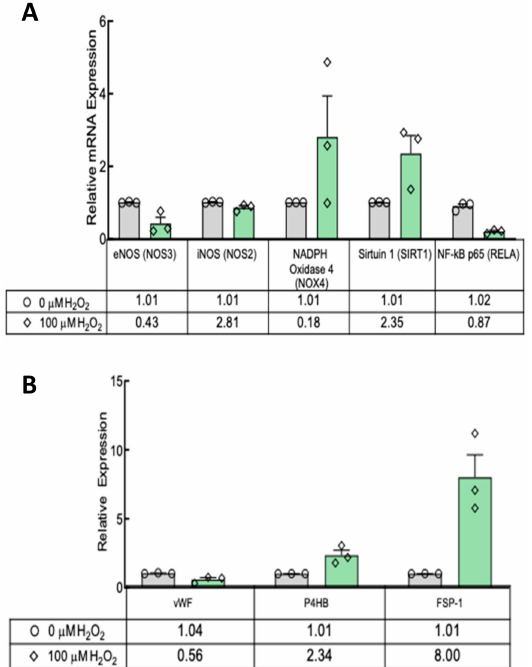
Figure 7. qRT-PCR of TEBVs shows SIRT1 expression increased significantly in TEBVs treated with 100 µ M H 2 O 2, and there was a reduction in CBECFC-specific protein expression. ( A ) eNOS levels decreased significantly, but iNOS expression increased nearly threefold in response. NOX4 expression also decreased significantly with H 2 O 2 treatment. NF-kB expression was una ff ected. ( B ) Expression of vWF specific to the CBECFCs was decreased in TEBVs treated with 100 µ M H 2 O 2 compared to controls. The relative expressions of hNDF-specific proteins, P4HB and FSP-1, were increased in treated vessels compared to controls. N = 3. Bars represent the mean ± SEM. # indicates p < 0.01. * indicates p <